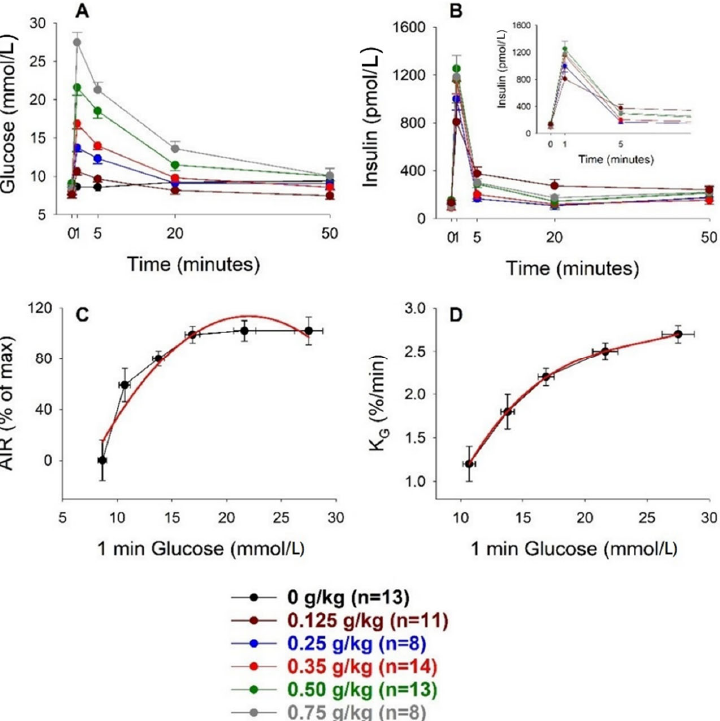
Figure 1. Glucose ( A ) and insulin (( B ) with insert for initial minutes) levels before and after intravenous administration of glucose (0–0.75 g/kg) and the relation between the 1 min glucose value and acute insulin response (AIR) ( C ) and glucose elimination rate (K G ) ( D ), respectively, in C57BL/6J mice. Means ± SEM are shown. n indicates the number of animals in each group. Red lines in the two lower panels indicate the best curve fit for the relations. Table 1. Body weight, acute insulin response (AIR), suprabasal (incremental) areas under the 0–60 min curves (AUC) for glucose and insulin levels, and glucose elimination rate (K G ) after intravenous administration of glucose at different dose levels in C57BL/6J mice. Means ± SEM are shown. n in ‐ dicates the number of animals in each group. NR not relevant.